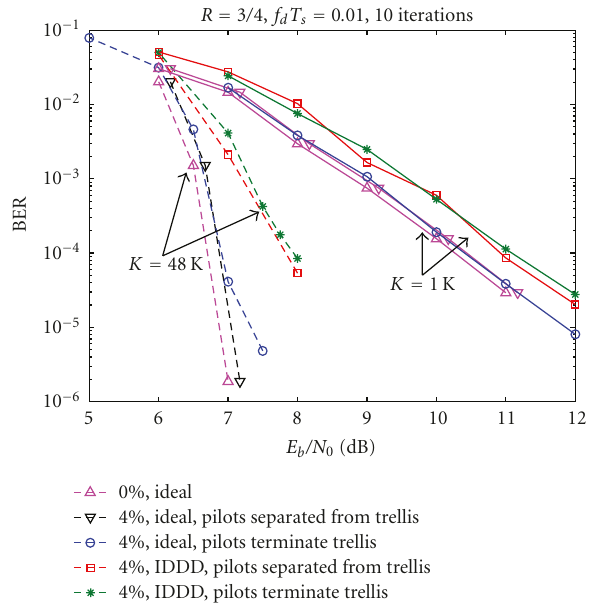
Figure 13: Comparison of BER performance for several transmis- sion/reception strategies for PA codes of large and small block sizes on correlated Rayleigh channels with f d T s = 0.01. Code rate 0.75, data block size 48 K and 1K, 4% of bandwidth expansion, filter length 65, 10 (global) iterations each with 4 (local) iterations for the outer